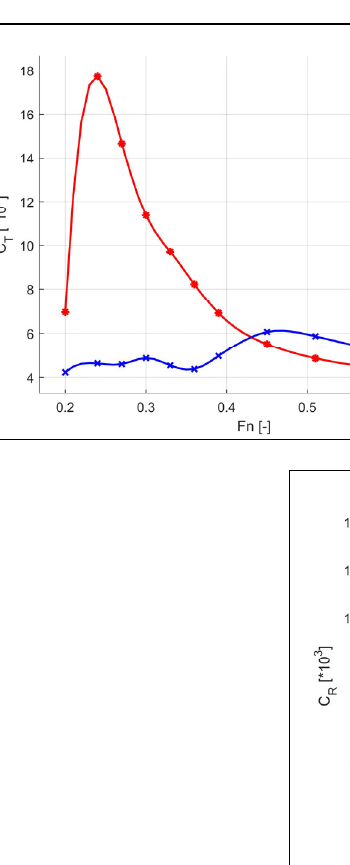
Figure 9. Sinkage ( left ) and trim ( right ) results of the catamaran in deep and shallow water.